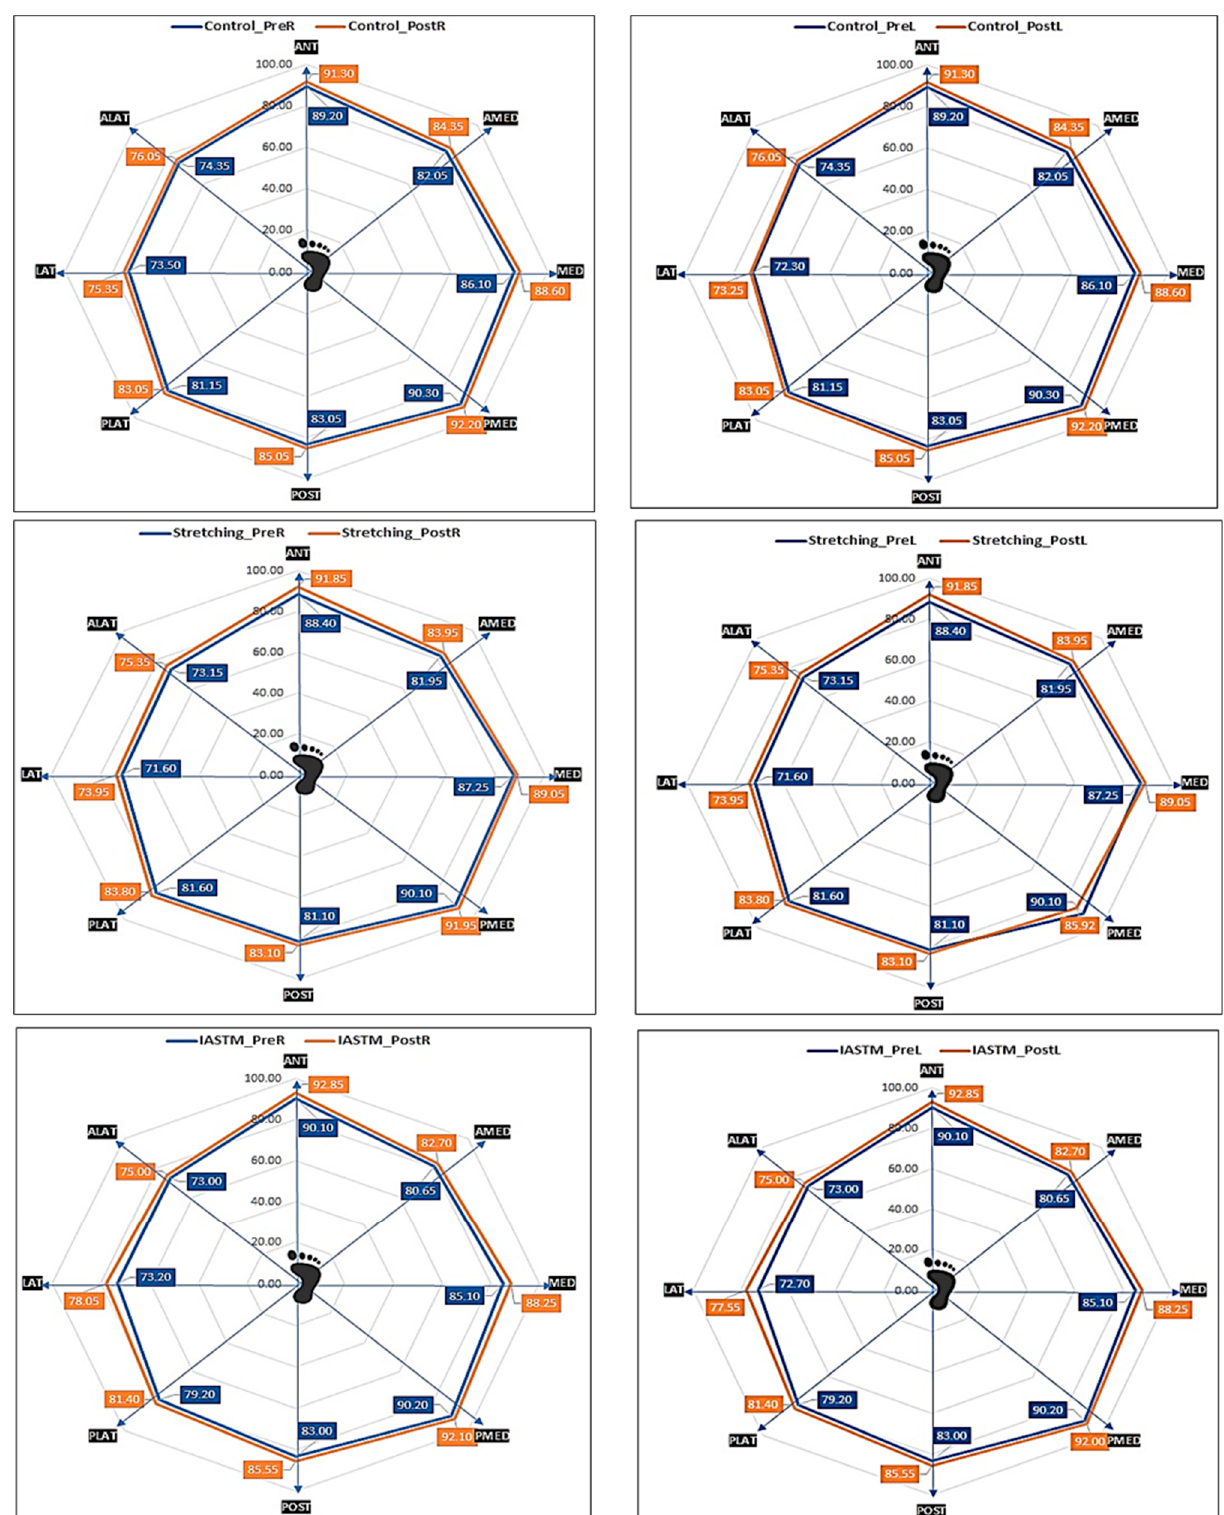
Figure 3. Comparison of different directions of dynamic balance test (SEBT) according to time (pre– post) and groups in left and right ankle joint. Note: Ant, anterior; AMED, anteromedial; MED, medial; PMED, posteromedial; POST, posterior; PLAT, posterolateral; LAT, lateral; ALAT, anterol- ateral.